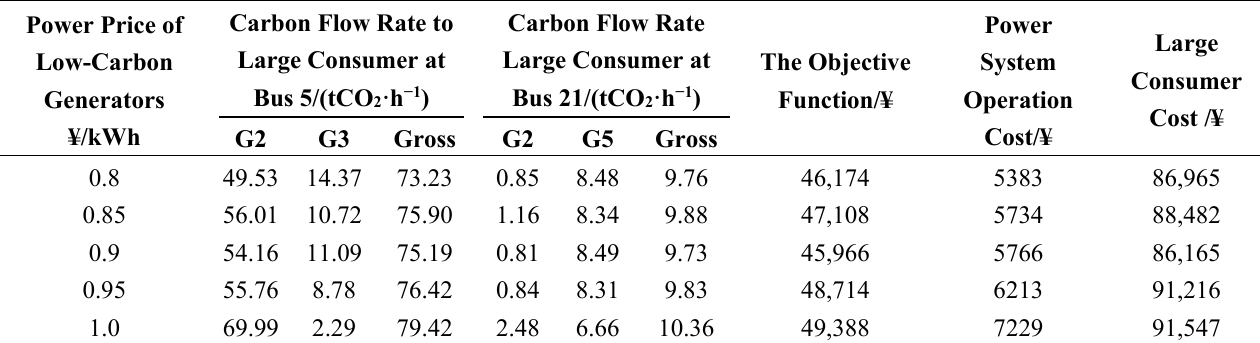
Table 10. Results under the condition of different electricity prices of low-carbon generators. Power Price